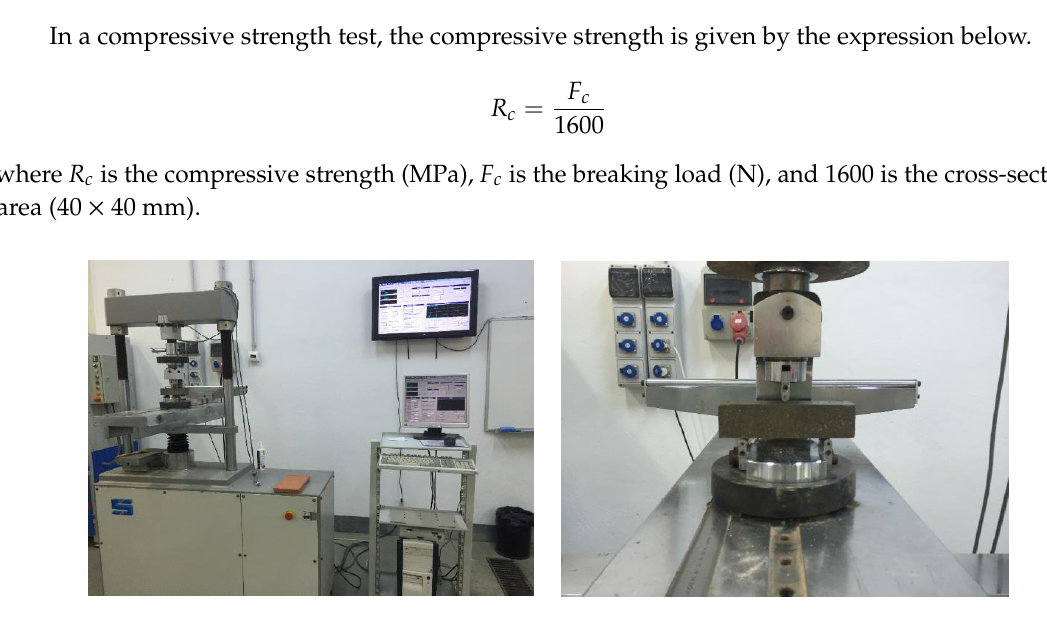
Figure 7. ETIMATIC-Proetisa H0224 used in tests.